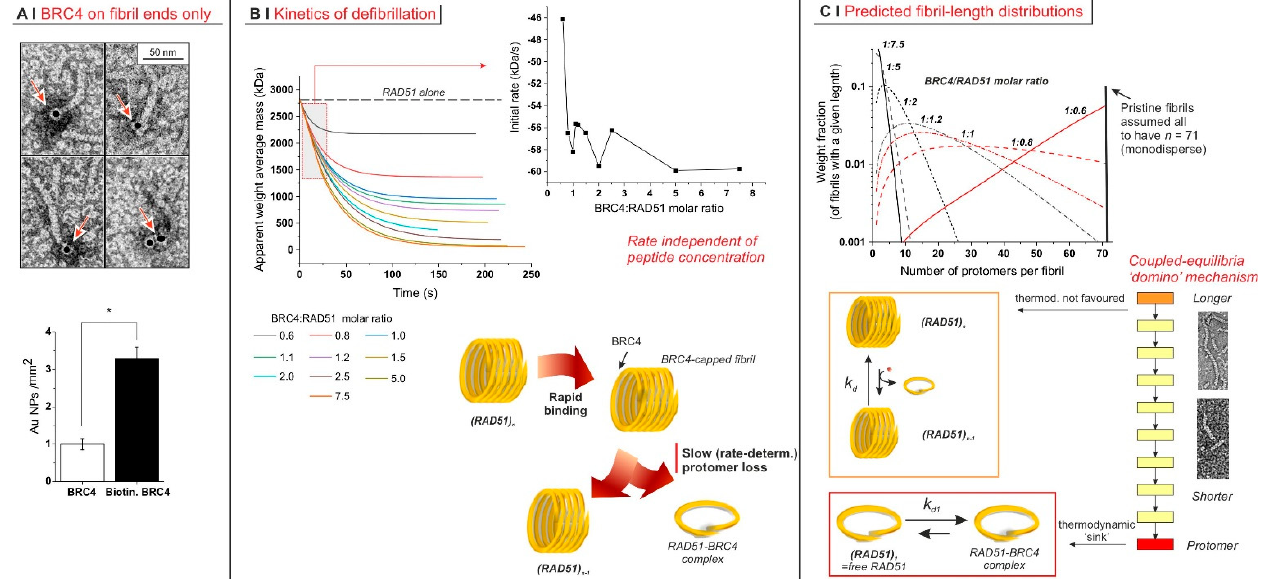
Figure 2. ( A ) Localization of biotinylated BRC4 peptide by avidin–gold labelling. The